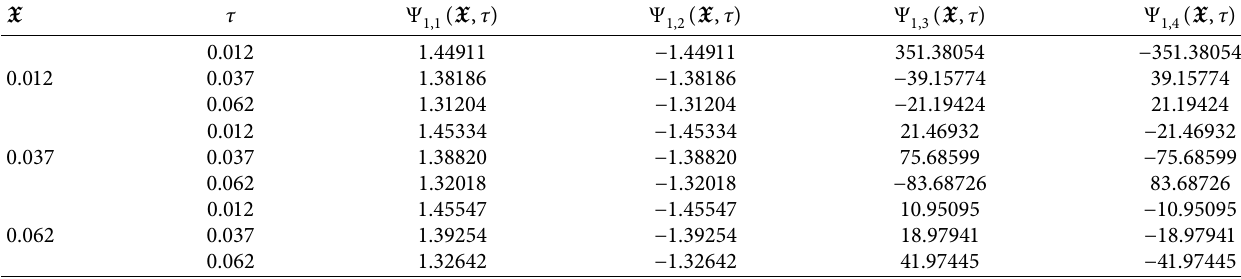
Table 1: The real part of exact solutions of CTFMNLSE (1) obtained by the TEM with several point sources through arbitrary.